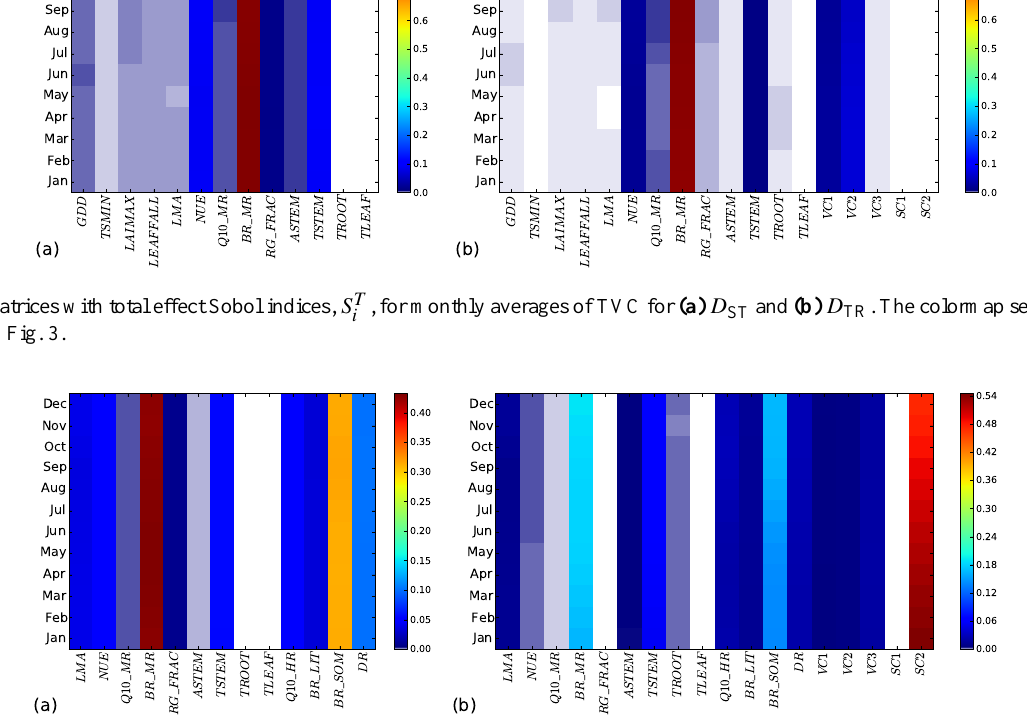
, for monthly averages of TSC for (a) D ST and (b) D TR . The colormap setup is similar i